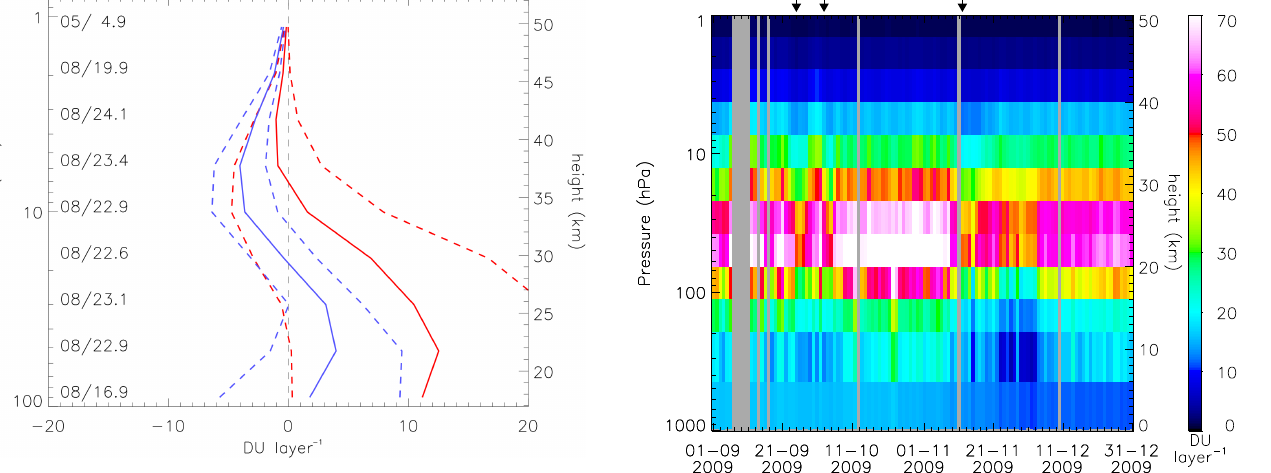
Fig. 17. A time series of the gridded GOME-2 profiles (DUlayer − 1 ) over Río Gallegos. The grey areas are missing GOME-2 data. The start of three episodes of ozone depletion are indicated by the arrows at the top of the